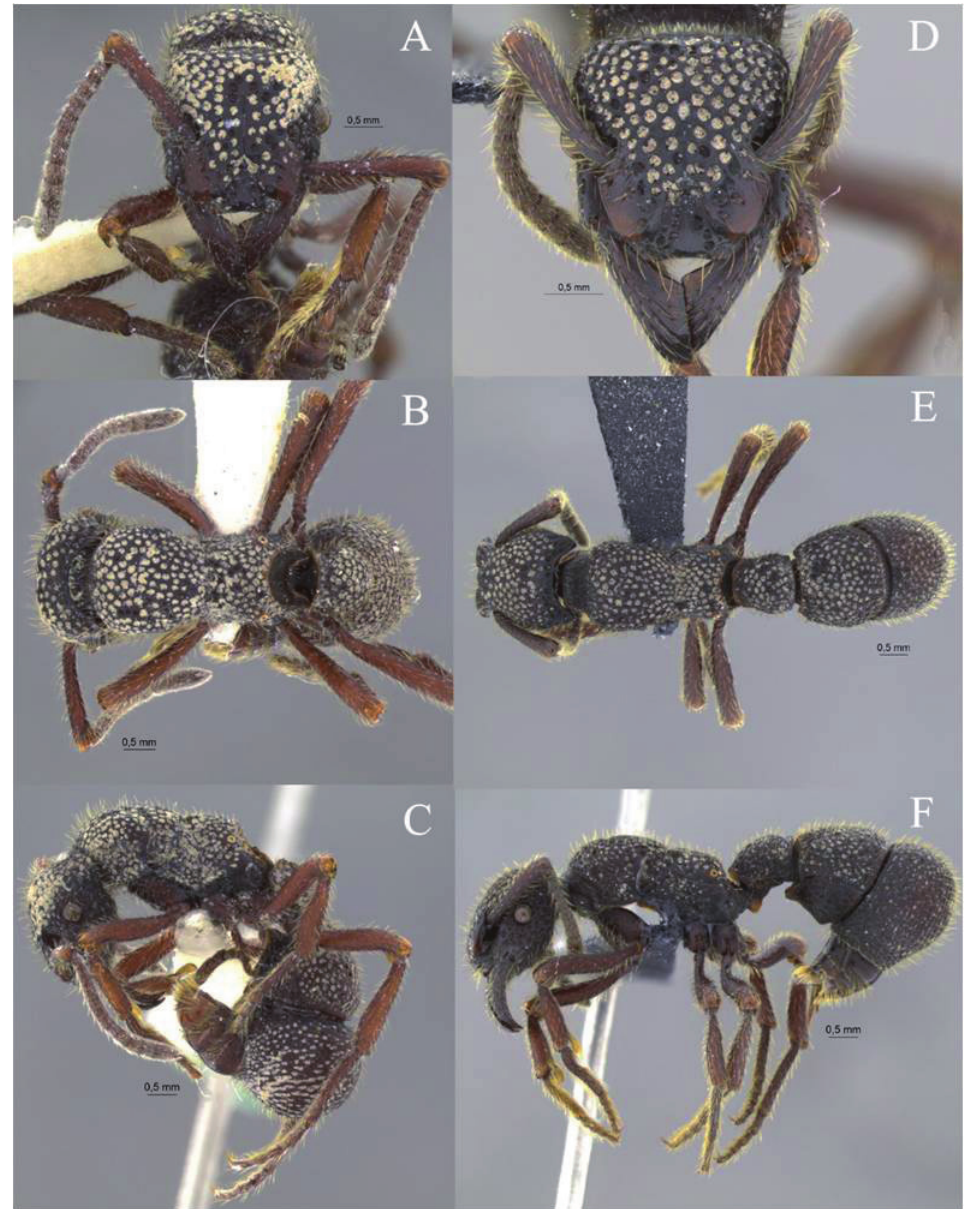
Fig 2. Holotype worker of Gnamptogenys vriesi in: full-face view (A), dorsal view (B) and lateral view (C); and newly collected worker in: full-face view (D), dorsal view (E) and lateral view